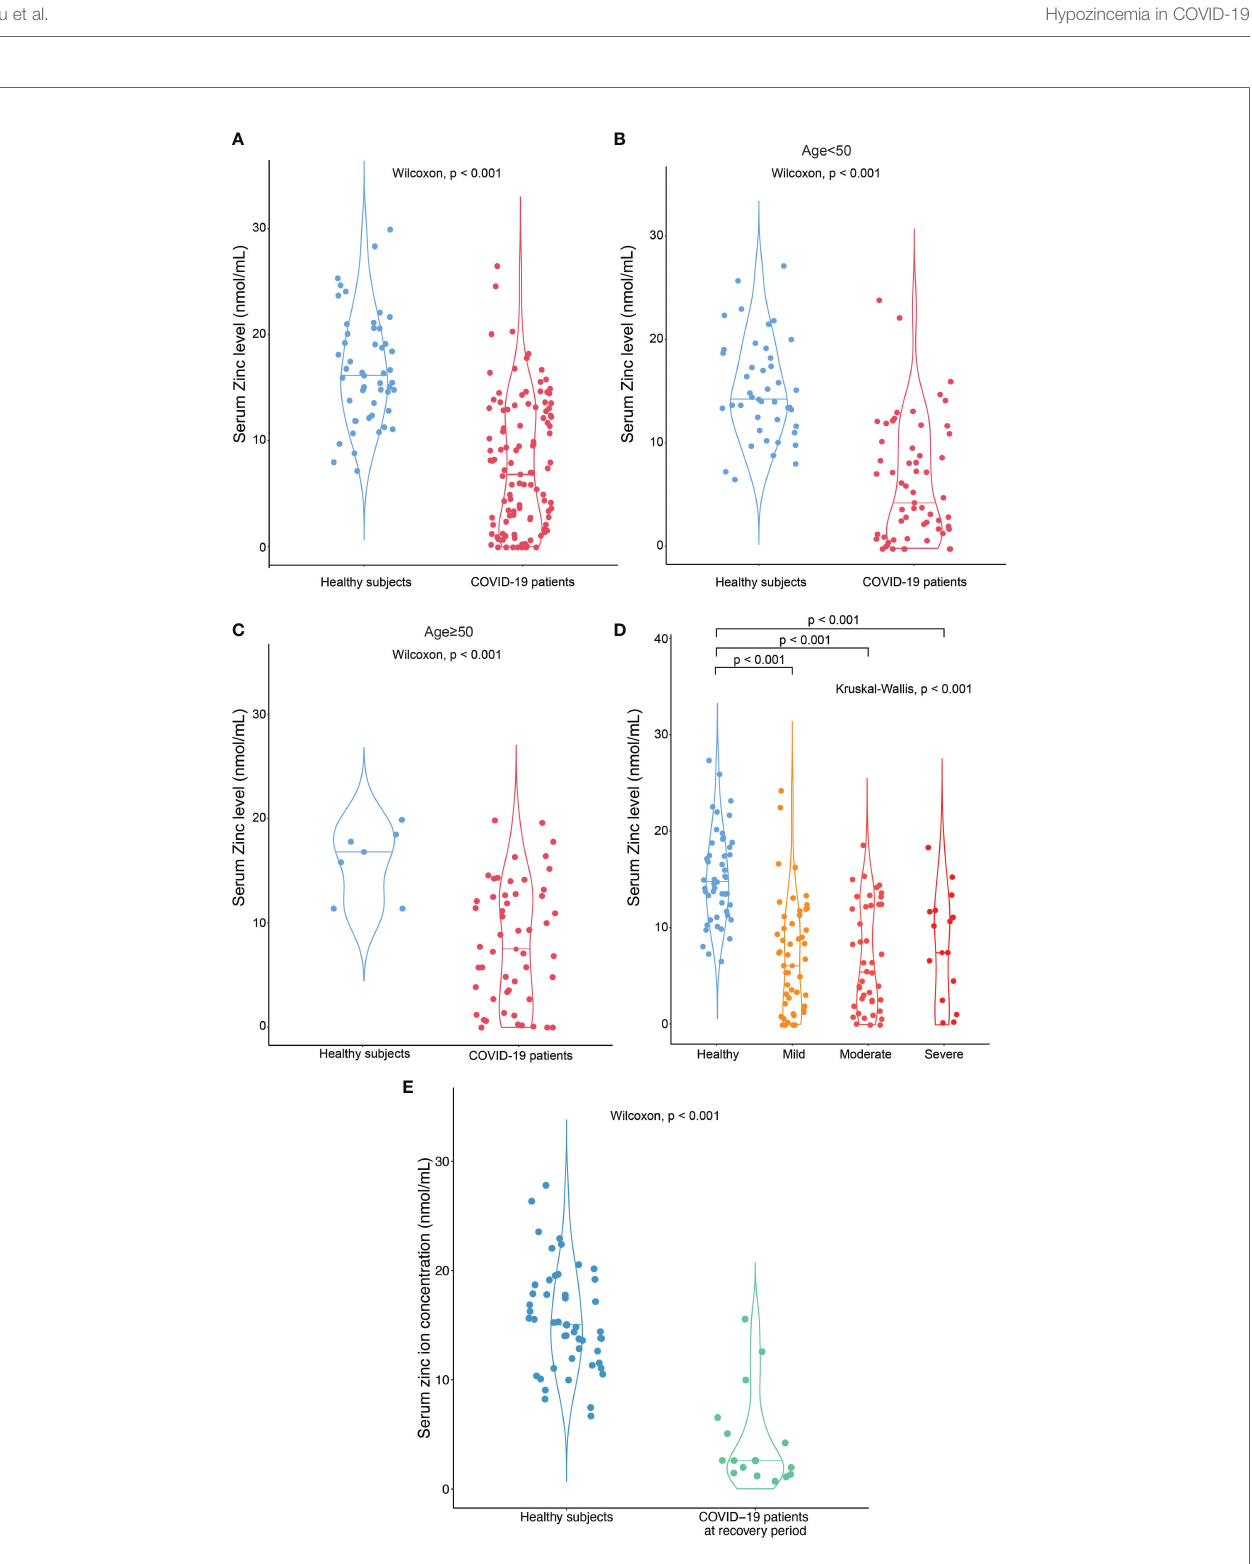
FIGURE 1 | Hypozincemia in patients with COVID-19. (A) Serum zinc ion concentrations in patients with COVID-19 (n = 114) were signi fi cantly lower than that in healthy subjects (n = 48). (B-D) The difference in serum zinc ion concentrations remained signi fi cant when the subjects were strati fi ed by age or disease severity – (B) subjects < 50 years old; (C) subjects ≥ 50 years old; (D) COVID-19 patients with different severity classi fi ed by their need for oxygen therapy and ventilatory support; signi fi cantly different between the indicated groups by Wilcoxon test; (E) Serum zinc ion concentration in patients with COVID-19 at recovery stage (after discharge to the hospital) (n = 15) were signi fi cantly lower than that in healthy subjects (n =